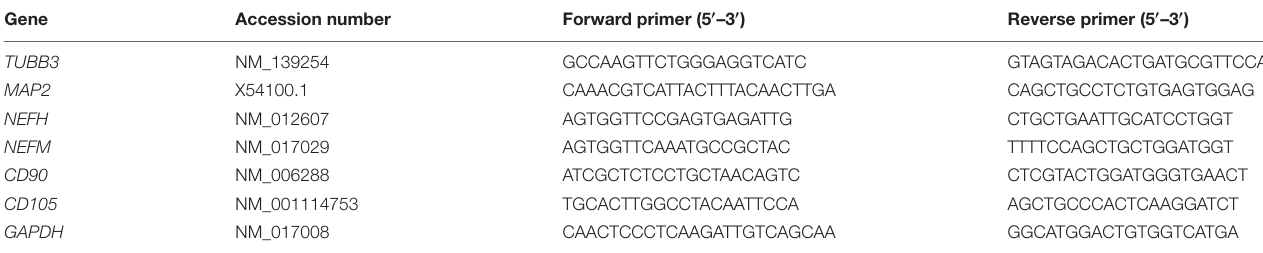
TABLE 1 | Primer sequences of the neuron markers used for RT-qPCR analysis. Gene Accession